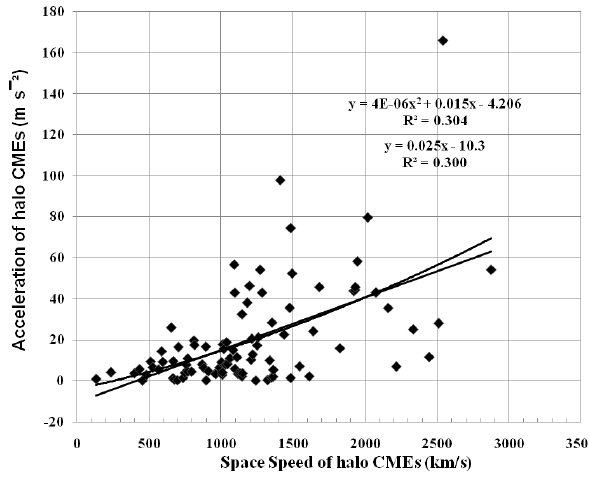
Figure 6. A plot of the space speed of HCMEs (km/s) versus the acceleration of accelerated HCMEs (m/s 2 ). The linear equation and two-degree polynomial are fitted to the space speed of accelerated HCMEs and the acceleration of accelerated